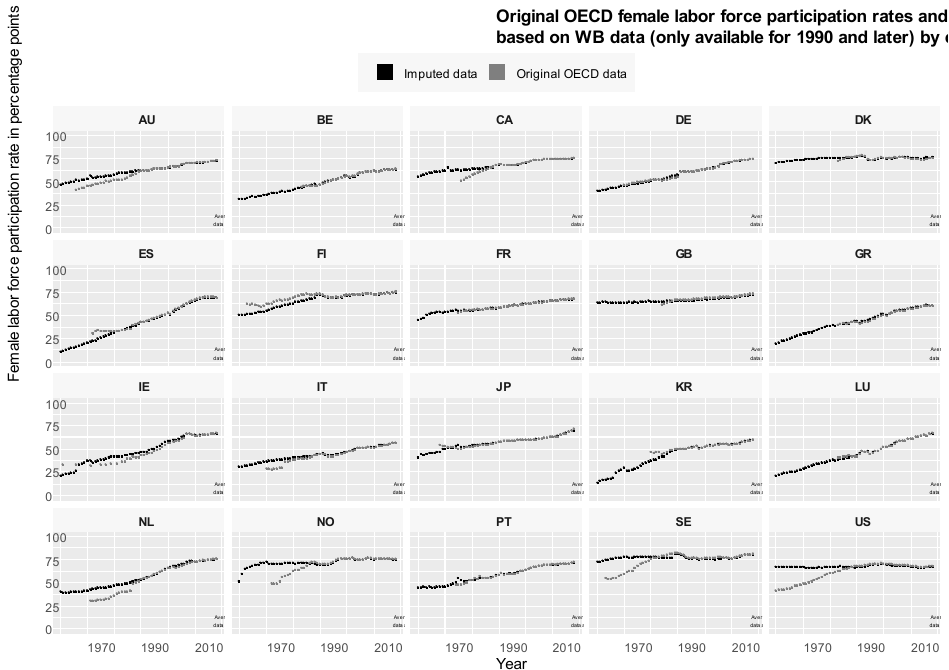
Source: WB & OECD data for country-year information on female LFP rates (1960-2018) Note: Variables used for the imputation of female LFP rates. Additional information such as basic descriptives and time series plots can be retrieved via https://data.worldbank.org/indicator/INDICATORNAME Indicator names: Country code; Year; Female LFP aged 15-64 ILO - SL.TLF.ACTI.FE.ZS (To be imputed; 52% coverage across all country-years from combined OECD and WB data); Yearly global mean of female LFP; Land area (sq. km) - AG.LND.TOTL.K2; Population density (people per sq. km of land area) - EN.POP.DNST; Population growth (annual %) - SP.POP.GROW; Population total - SP.POP.TOTL; Rural population total - SP.RUR.TOTL; Rural population growth (annual %) - SP.RUR.TOTL.ZG; Rurual population (% of total population) - SP.RUR.TOTL.ZS; Urban population growth (annual %) - SP.URB.GROW.